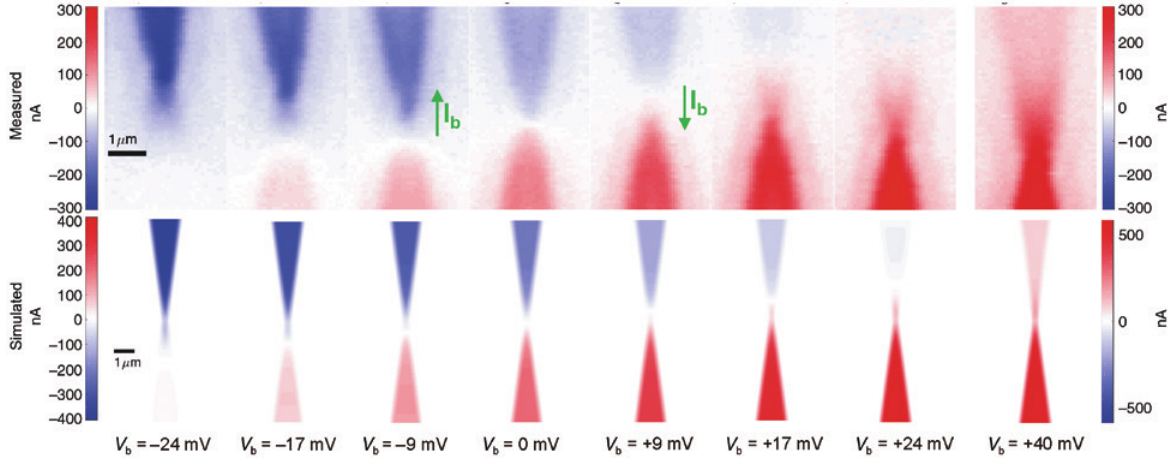
Figure 4: Thermocurrents maps with applied